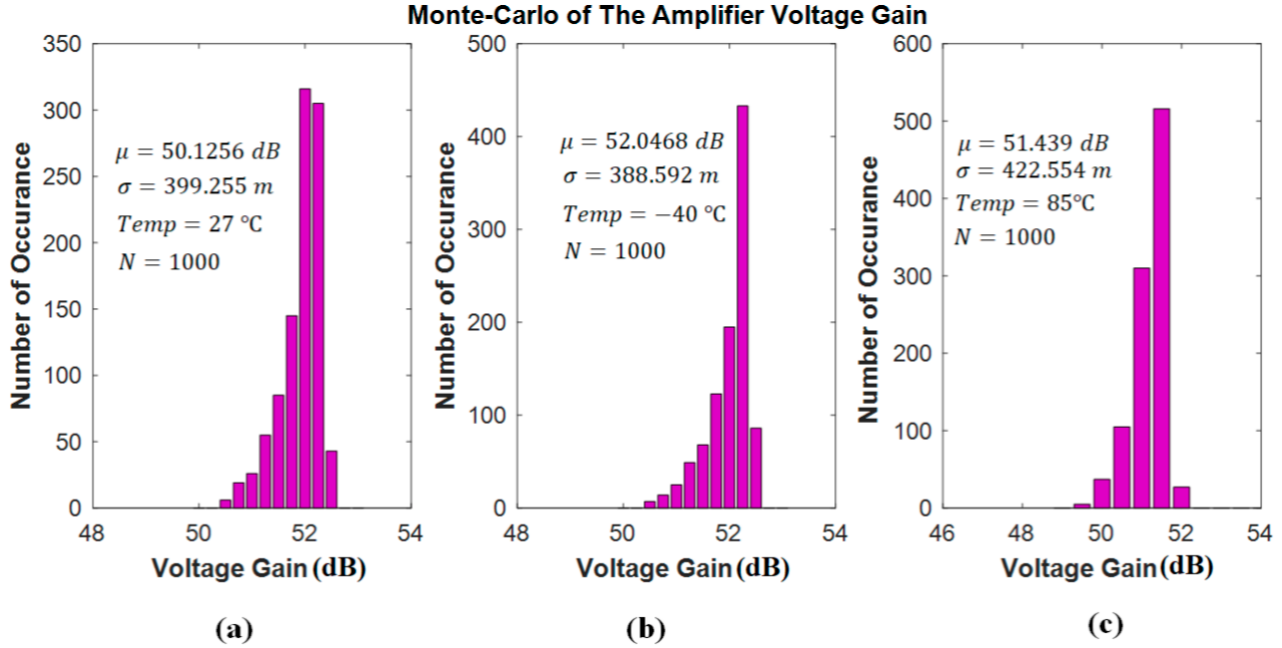
Figure 8. The Monte Carlo analysis of the proposed amplifier’s voltage gain for various processes and mismatching at ( a ) 27, ( b ) − 40, and ( c ) 85 °C, respectively. Additionally, the voltage gain varieties versus power supply voltage are displayed in Figure 9. Based on the results, with ± 10% changes in power supply, the voltage gain varies between 52.38 and 52.16 dB, while the amplifier gain changes between 53.13 and 51.53 dB when the power supply alters by ±20%.